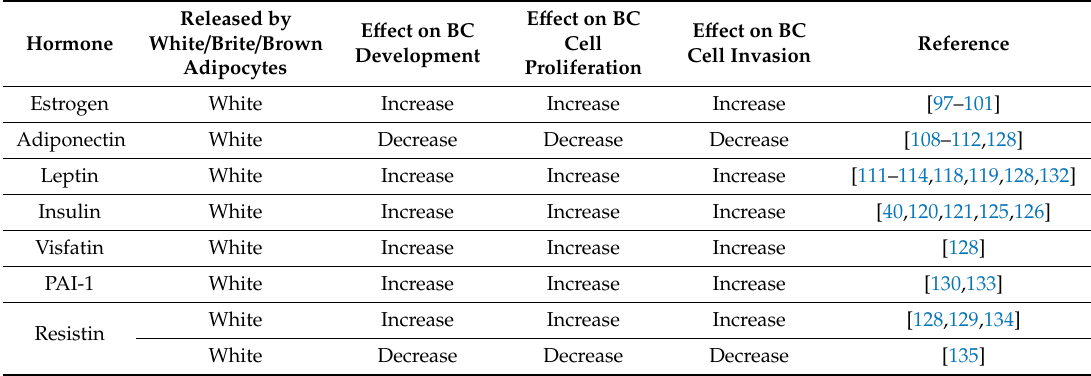
Table 2. Adipocytes regulate breast cancer via their released